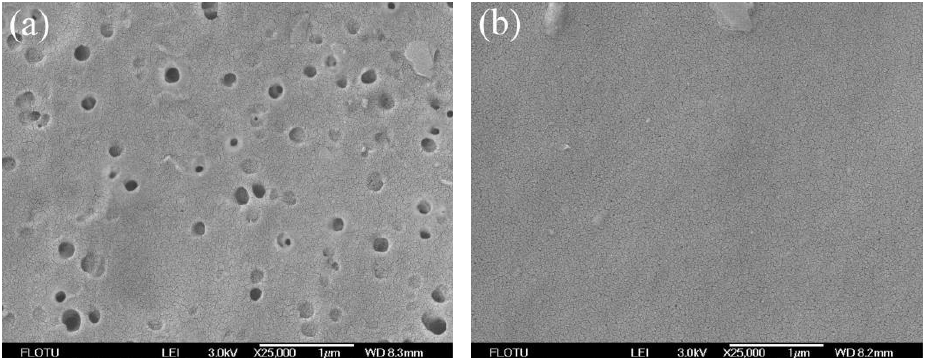
Figure 4. SEM photomicrographs of the top surface of PPSU UF membranes prepared by single and compound additives with PEG as polymeric pore-forming agent: ( a ) PPSU5; ( b ) PPSU6.